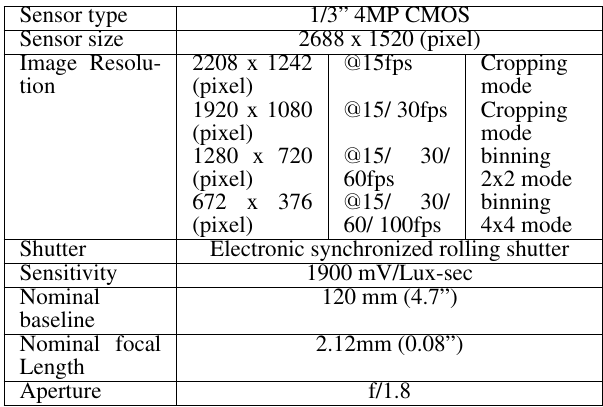
Table 1. ZED2 specifications